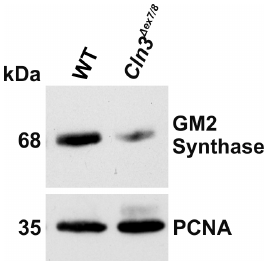
Figure 6. Reduced expression of GM2 synthase in Cln3 Δ ex7/8 cells. Cell lysates of WT and Cln3 Δ ex7/8 cells were analyzed by Western blot using an antibody specific for the GM2 synthase. PCNA (proliferating cell nuclear antigen) was used as a loading control. Data are representative for three independent experiments.